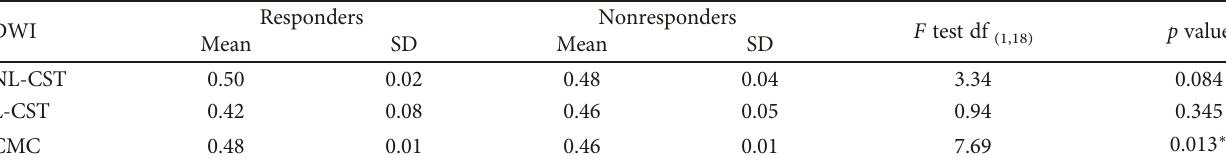
Signi fi cant e ff ect of DW-FA between groups: Wilks ’ lambda = 0 62 , F 3 , 16 = 3 24 , p = 0 05 . Post hoc univariate tests revealed FA from tracts of the CMC ( F 1 , 18 = 7 69 , p = 0 013 ) was signi fi cantly higher in responders versus